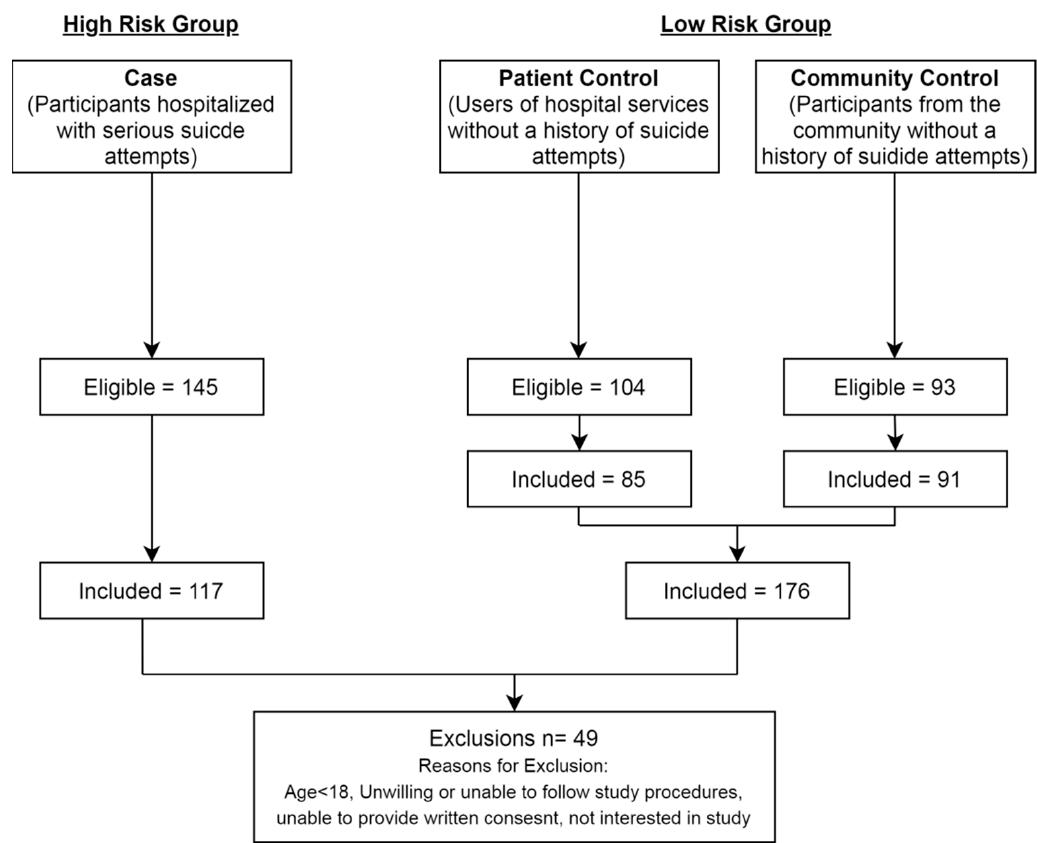
Figure 1. Flow diagram outlining study participants, adapted and repurposed from original study recruitment plan from Samaan et al. with permission [19].